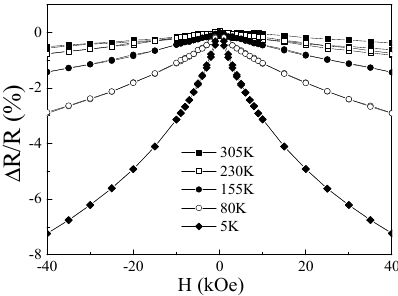
Figure 18. ∆ R/R(H) dependence measured in as-prepared Co 20 Cu 80 microwires. Reproduced from reference [83], Figure 1a.